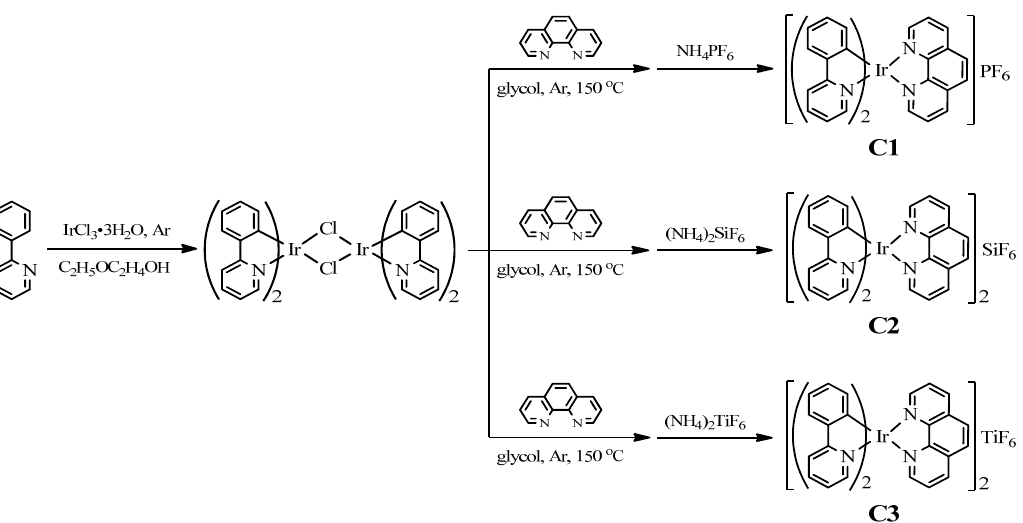
Figure 1. Synthetic route and chemical structures of the cationic iridium(III) complexes.